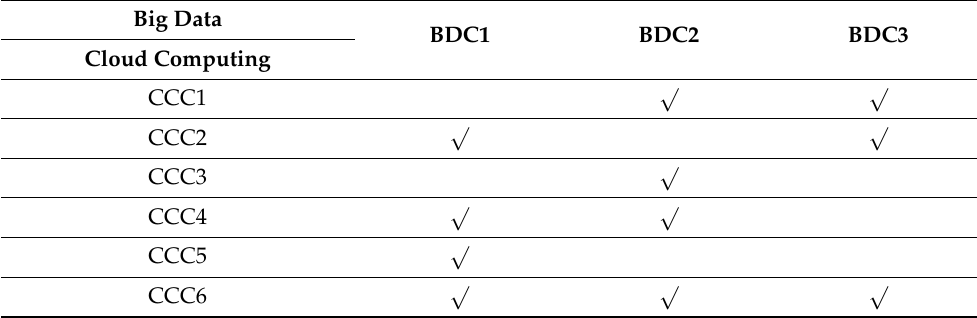
Table 5. Big Data and Cloud Computing security